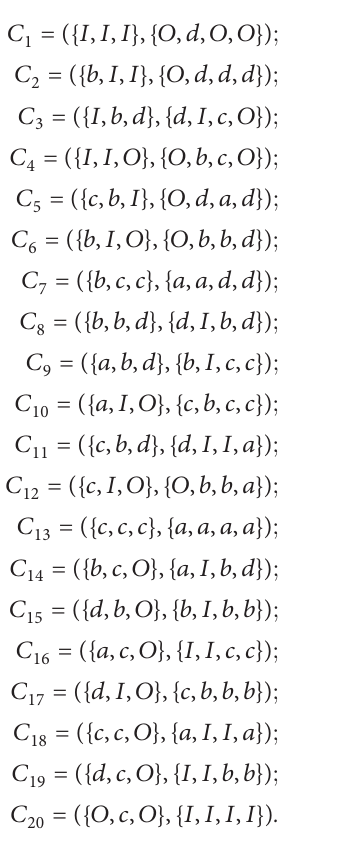
Figure 2: Hasse diagram of ( L, ∧ , ∨ , ′ , ⟶ , O,I ) . Table 4: Implication operation between the linguistic truth